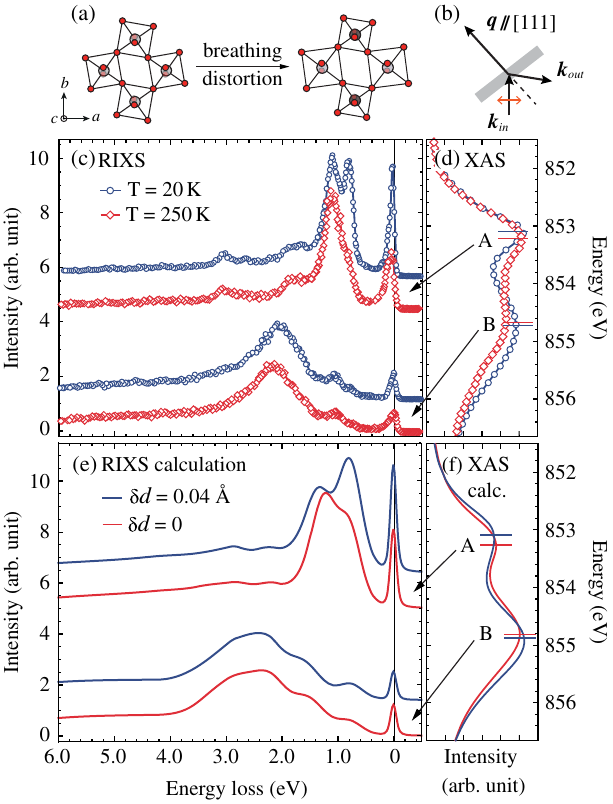
FIG. 1. (a) Sketch of the breathing lattice distortion across the MIT in the R NiO 3 . (b) The scattering geometry used in the experiment, where the red arrow indicates the electric vector of the photon polarization. (c) RIXS spectra and (d) XAS for the NdNiO 3 film at temperatures below and above T . The RIXS MIT spectra were collected at q 111 ¼ 0 . 194 with incident photon energy tuned to the resonant peaks A and B marked by bars in panel (d). (e) RIXS spectra and (f) XAS calculated using a double-cluster model with δ d ¼ 0 . 04 Å (blue) and 0 Å (red) with the experimental geometry and light polarization in (c) and